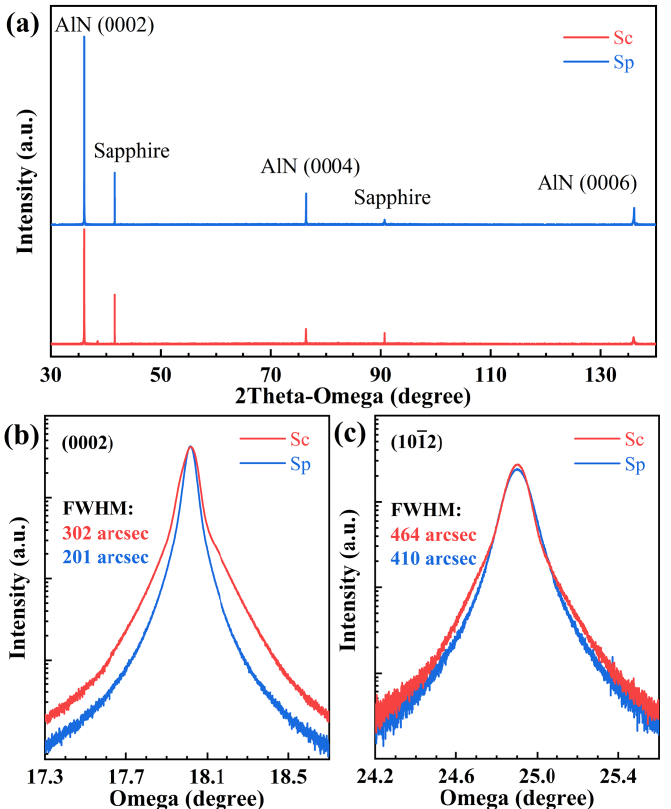
(cid:0) (cid:1) 1012 plane X-ray rocking curves